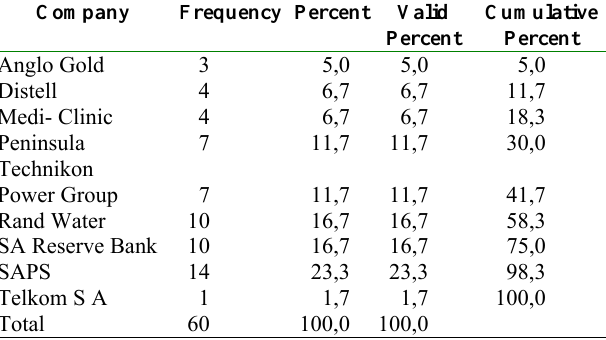
Table 2: distribution of unit leaders across sampled